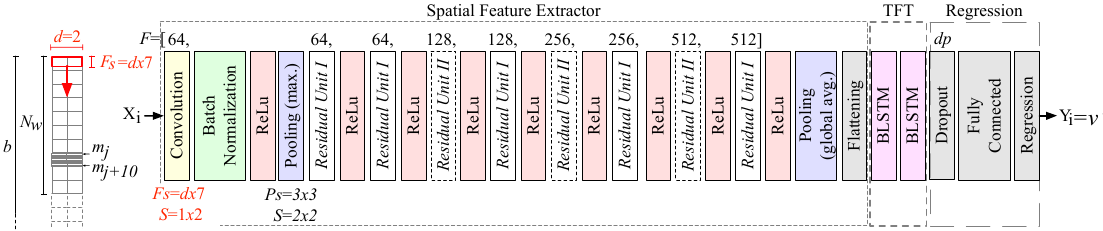
Figure 4. Detailed overview of our deep learning (DL) architecture: The deeper the network, the more spatial features (from 64 to 512) we extract. The two BLSTM layers track the temporal emergence of f s in the “temporal feature tracker” (TFT). The Residual Units of type I and II are also depicted in Figure